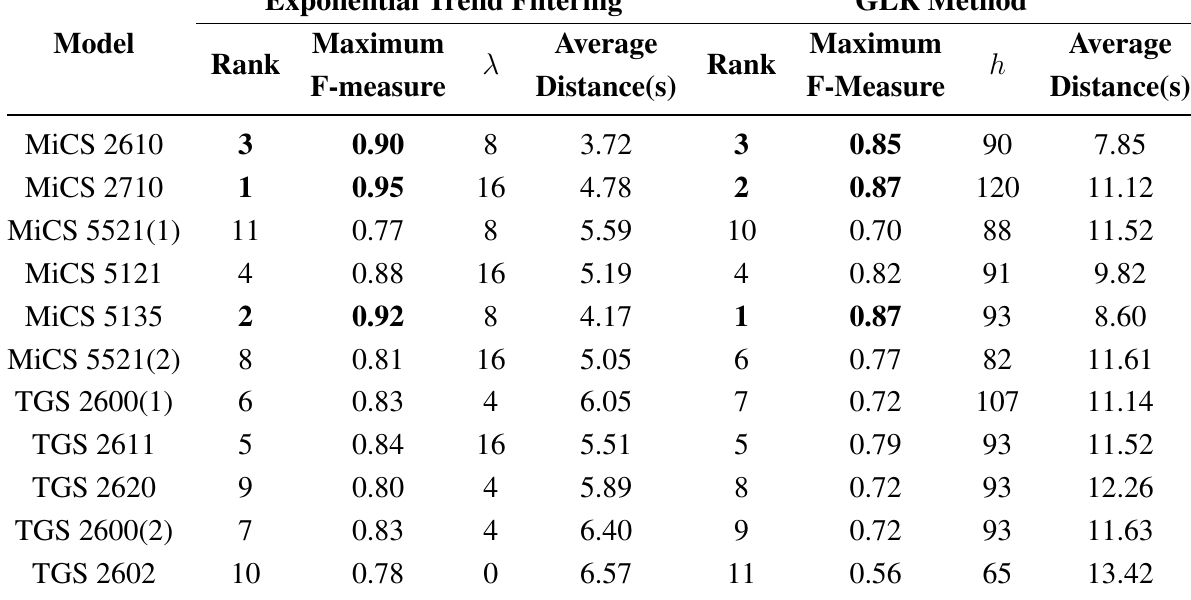
Table 2. Comparison between the TREFEX and the GLR algorithm. TREFEX outperforms GLR both in terms of the maximum F-measure and the average distance of the alarms from the change points. The value of the selected parameters ( λ for TREFEX, h for GLR) are also given. The ranking of the sensors w.r.t. maximum F-measure shows good agreement between the two algorithms regarding which of the sensors are most suitable to detect change points for the given